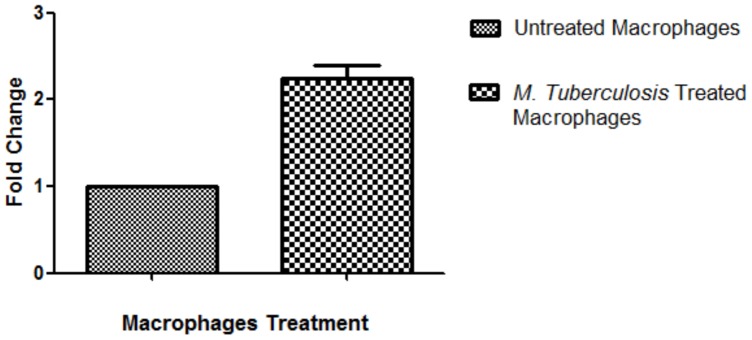

Mycobacterium tuberculosis (H37Rv) infection induces the over-expression of FAM46A RNA in macrophages.Total RNA was extracted from macrophages that were infected with M. tuberculosis (H37Rv) for 12 hours and uninfected macrophages, respectively. Extracted RNAs were subjected to quantitative real-time PCR for FAM46A gene amplification. Copy number was normalized to that of uninfected macrophages.